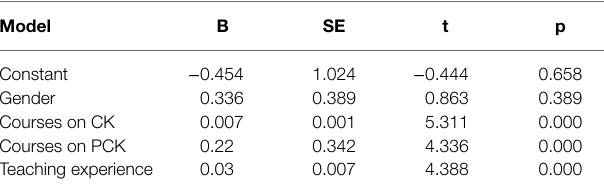
TABLE 7 | Results of multiple regression analyses with PCK as